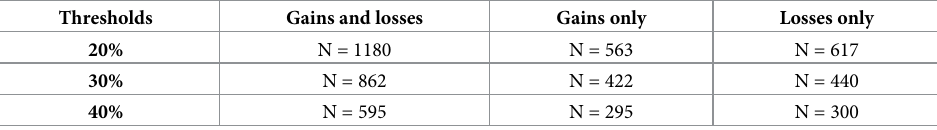
Table 2. Effect of different thresholds on the identification of behavioral gains and losses. Thresholds Gains and losses Gains only Losses only 20% N = 1180 N = 295 N =